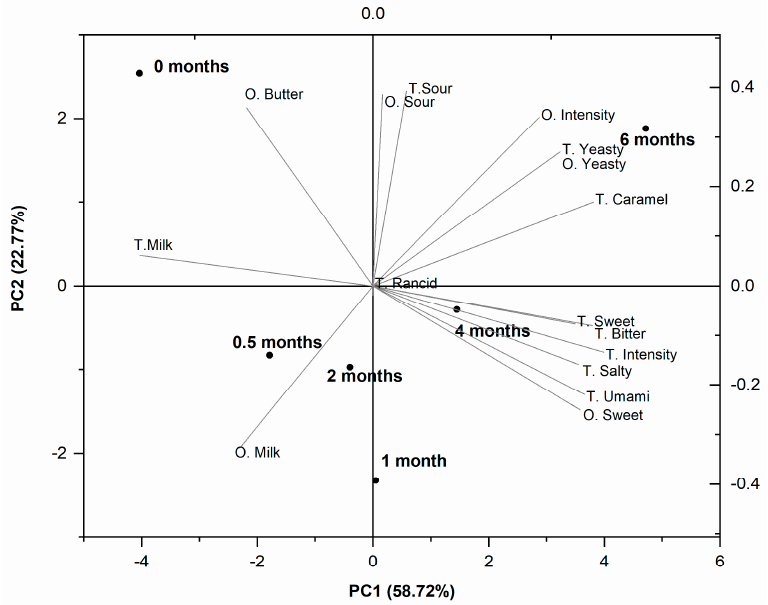
Figure 7. Principal component analysis (PCA) biplot of odor (O) and taste (T) attributes of RO-cheese during ripening. Cheeses are indicated by ripening time. PC: principal component.